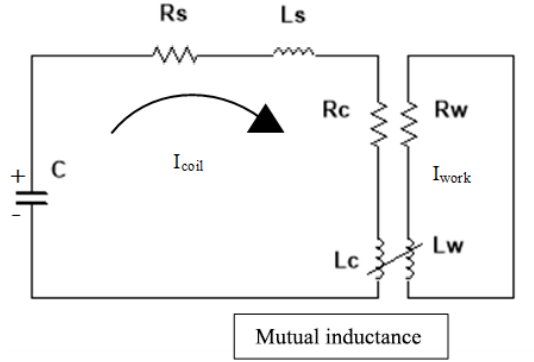
holder system was fabricated and tested. With this method, the wrinkling of the edges was reduced, and the flow of flange and deformation behaviour was